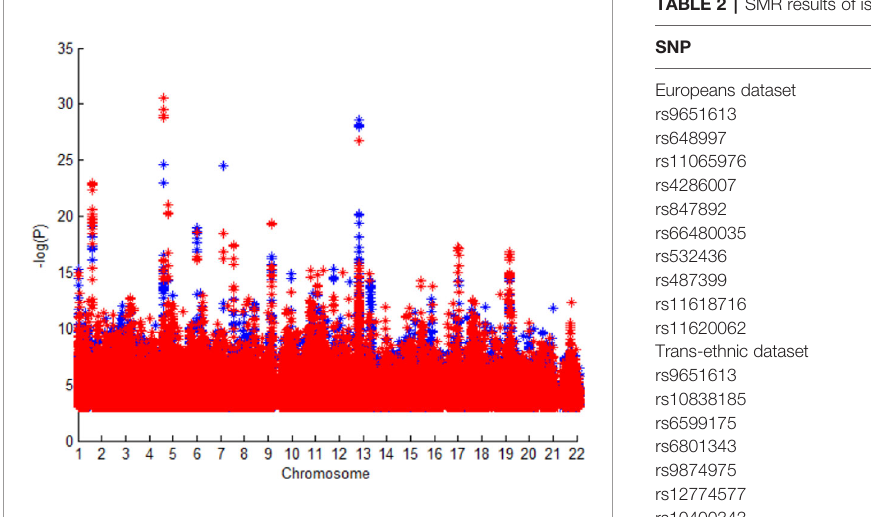
FIGURE 2 | P value of SNPs in GWAS1 and GWAS2.